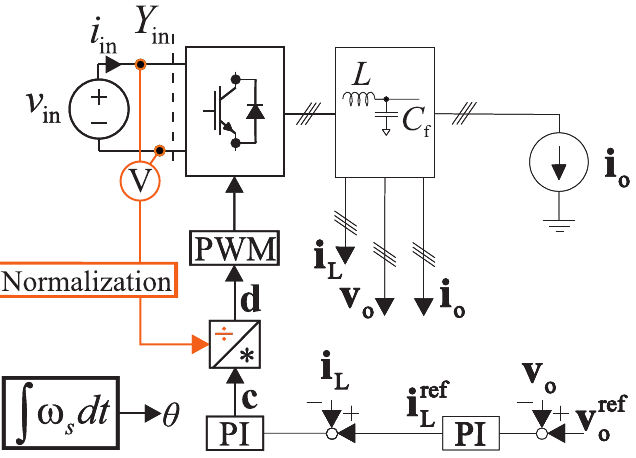
Figure 1. Simplified block diagram of the analyzed